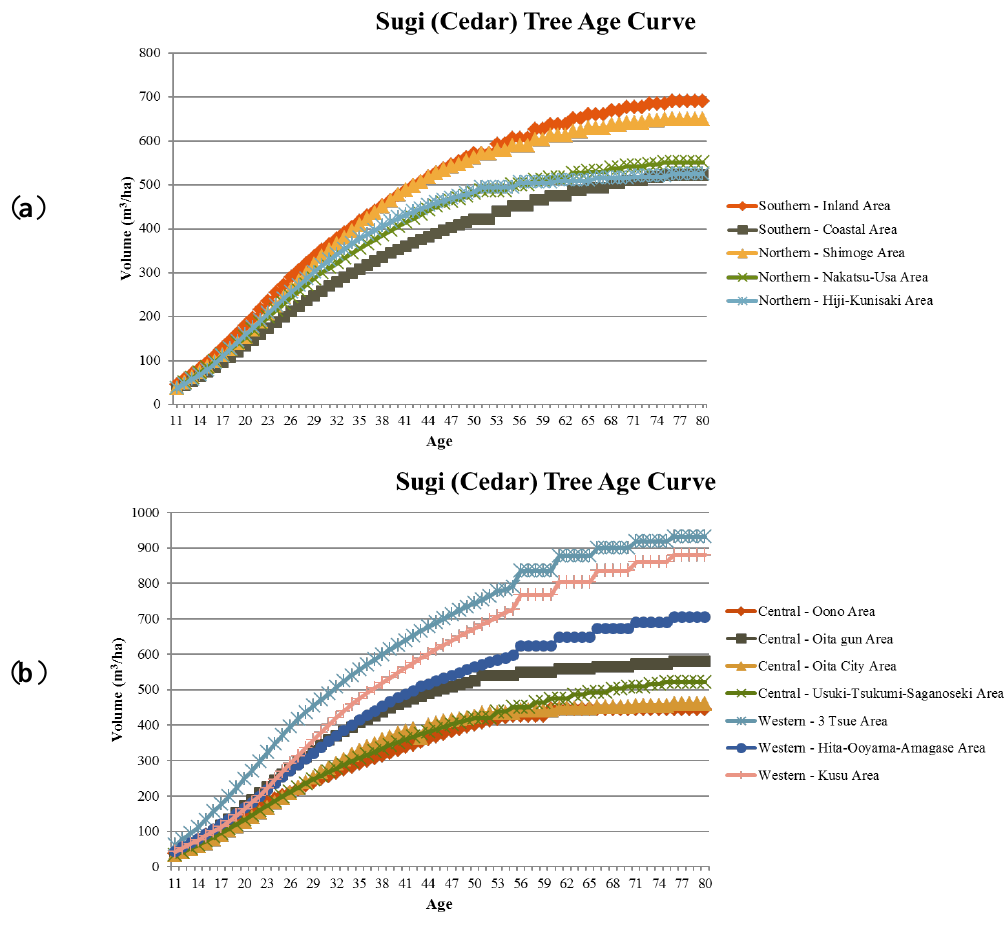
Figure 10. Stem volume as a function of tree ages for ( a , b ) the Sugi (cedar) and ( c ) the saw tooth oak, in Oita Prefecture. The difference of stem volume growth among the different regions in Oita is